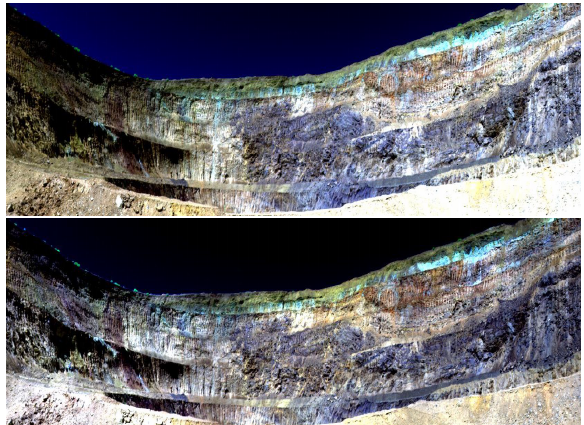
Figure 3. SPECIM Fenix mine face scanning scene, example 1, false color composite (R:2200nm, G: 1050nm, B:610nm). range between 400 and 2450 nm, The scan angle swath is 90 ◦ , the solar zenith angle was at 38.7 ◦ , and the average observation distance between sensor and mine face was approximately 150 m. The image results show that the variability of the illumina- tion in dependency of the observation direction can be mostly reduced by statistical means.